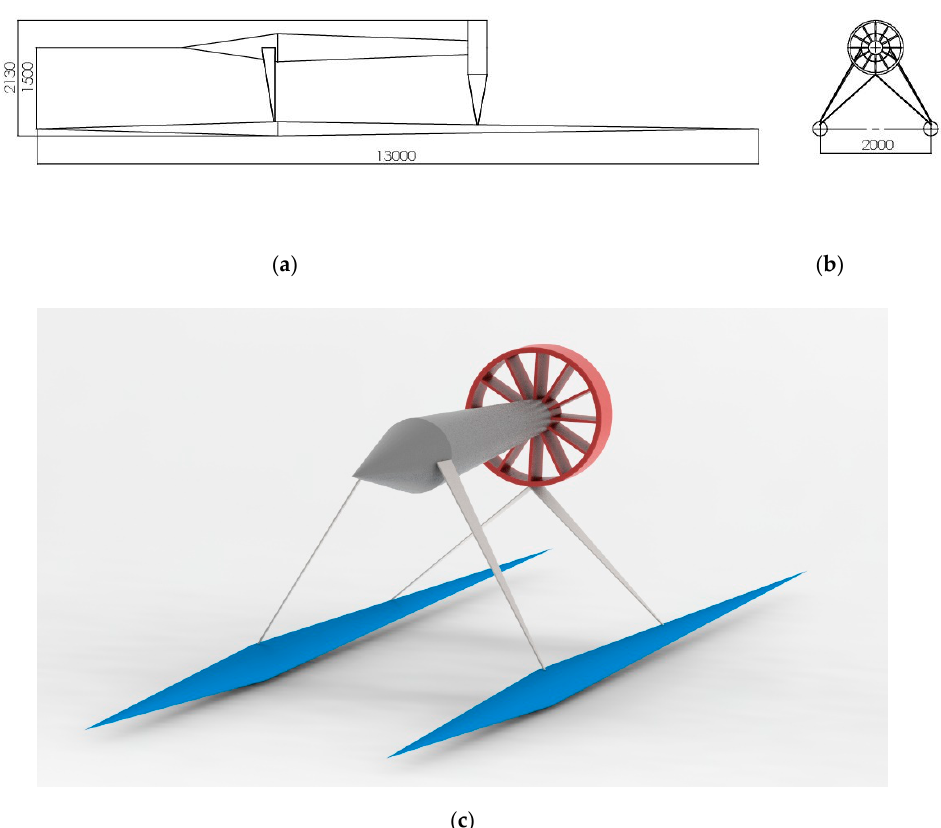
Figure 5. Sketch of a 1:4 model of the high-speed laminar SWATH ferry. ( a ) Side view; ( b ) front view; ( c ) 3D view.